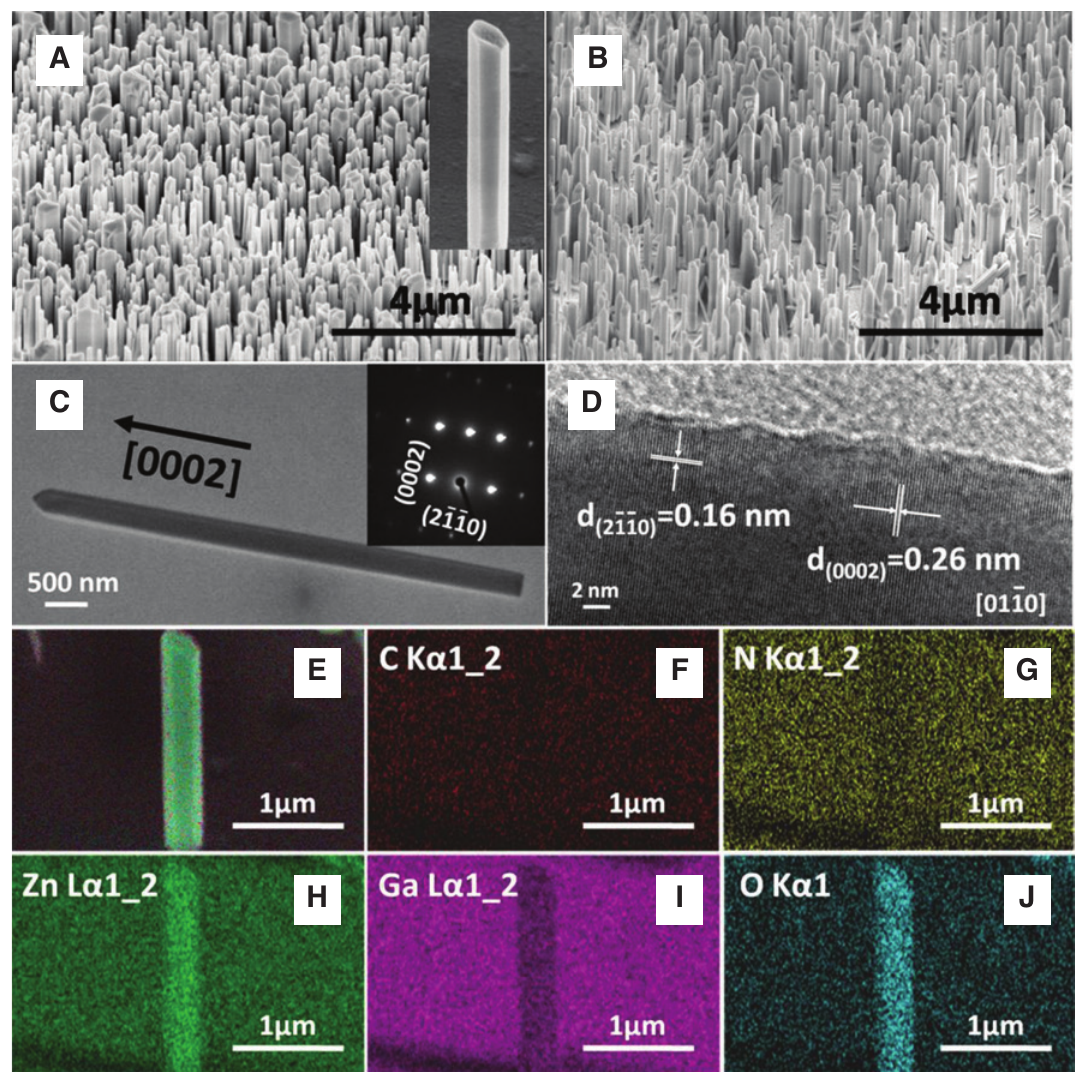
Figure 2: Microstructure characterization of the device. SEM images of ZnO NR arrays prepared on p-GaN substrates without (A) and with (B) graphene plasmon layer insertion. The inset of (A) shows a single smooth ZnO NR. (C) TEM image of ZnO NR. The inset displays the SAED pattern along the [011̅0] zone axis of a wurtzite structure. (D) HRTEM image with clear lattice fringes showing interplanar spacings of 0.26 and 0.16 nm, corresponding to the orthogonal (0002) and (21̅1̅0) planes of wurtzite ZnO. (E–J) EDX mapping results of single ZnO NR on graphene-covered p-GaN